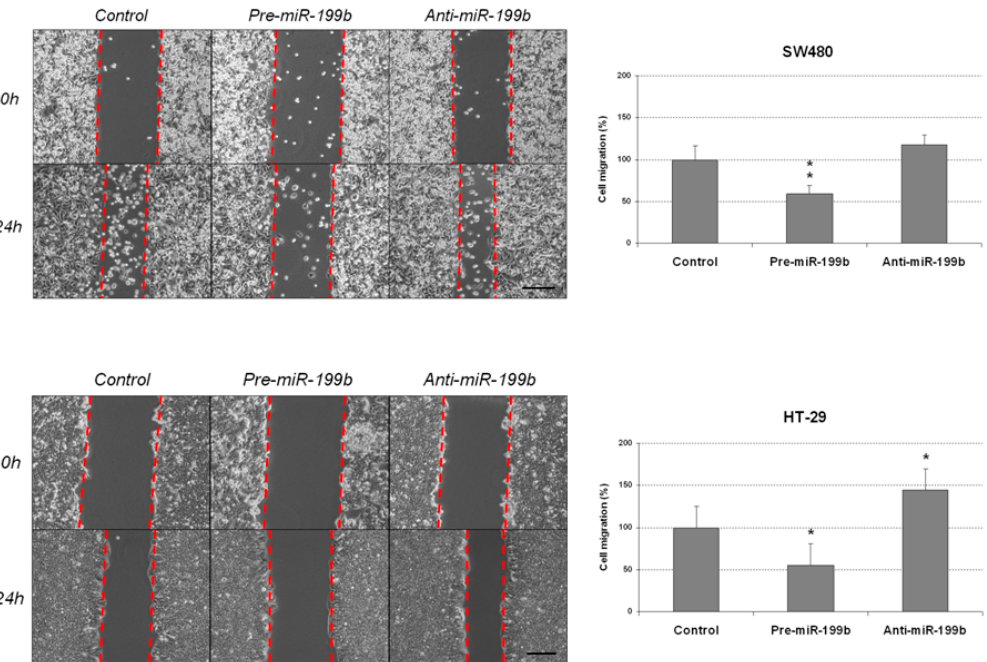
Figure 1. MiR-199b modulates cell migration in CRC cells. Wound-healing assay showing migration of SW480 and HT-29 cell lines after transfection with pre-miR-199b and anti-miR-199b. Dashed lines represent the migration border; * p < 0.05; ** p < 0.01. Scale bar: 200 µm.